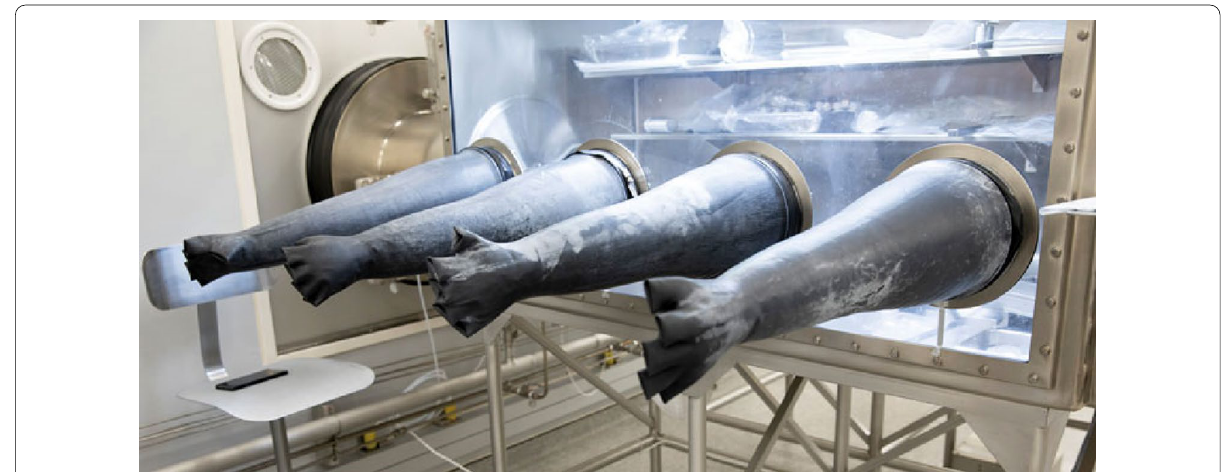
Fig. 2 Gloves in the sealed cabinet inflate outward all the time (Lisa